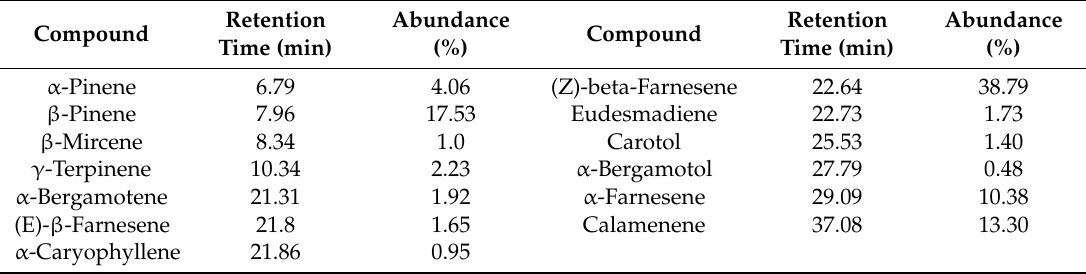
Table 1. Major compounds of the hexanic extract of Eryngium carlinae inflorescences.